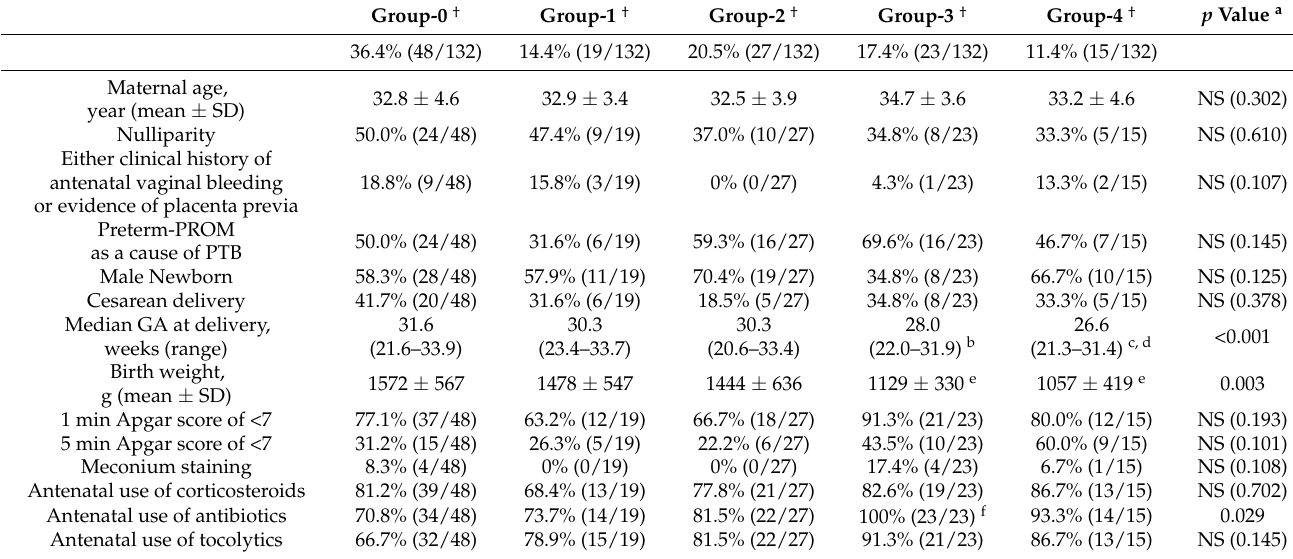
Table 1. Clinical characteristics and pregnancy outcomes according to the progression of acute histologic chorioamnionitis (acute-HCA) in extra-placental membranes (EPM).